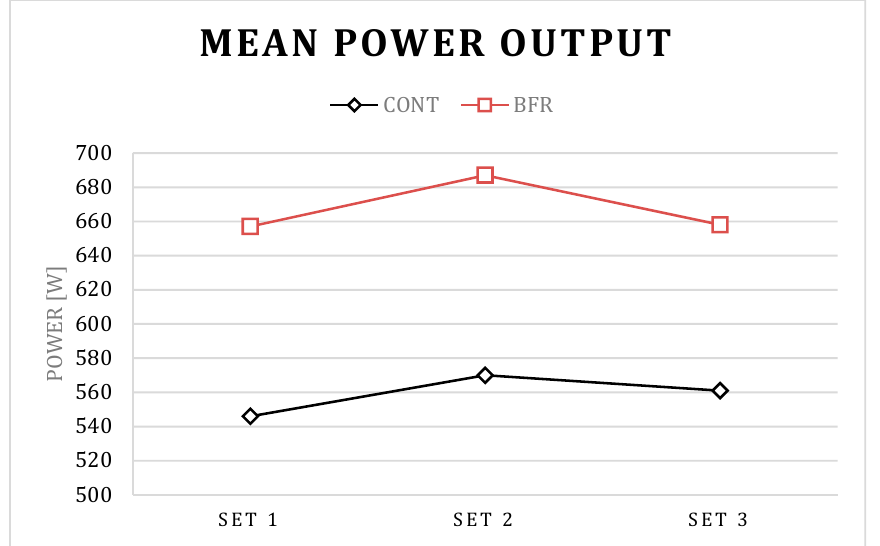
Figure 1. Mean power output for the BFR and CONT conditions during three successive sets of the bench press